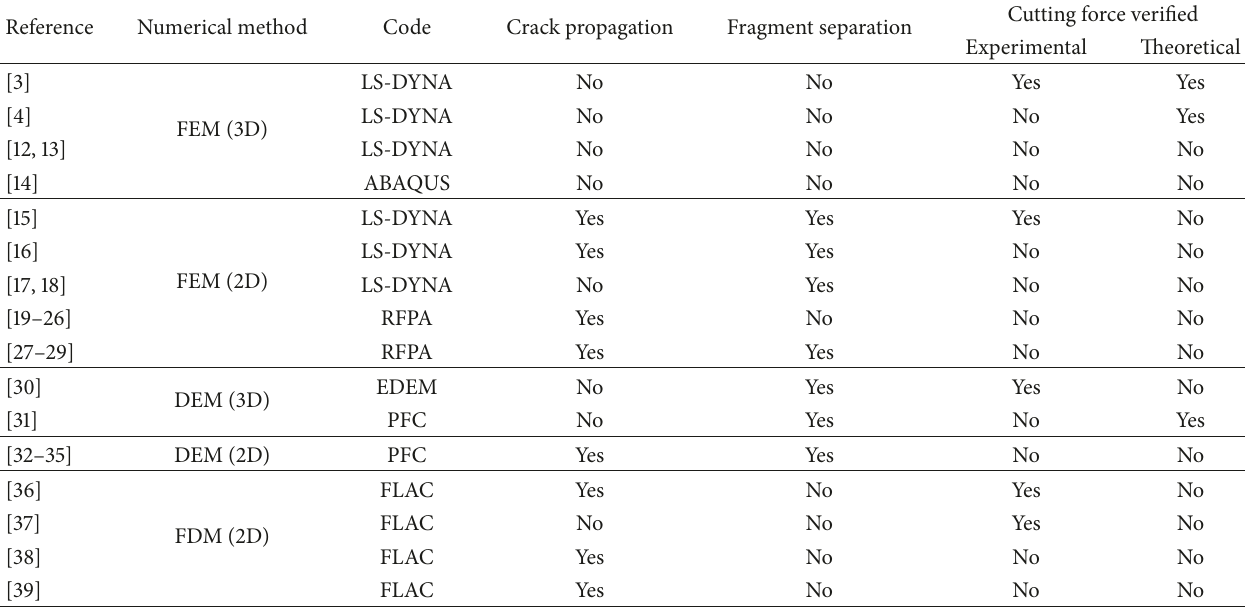
Table 1: Various numerical methods for fragment separation.